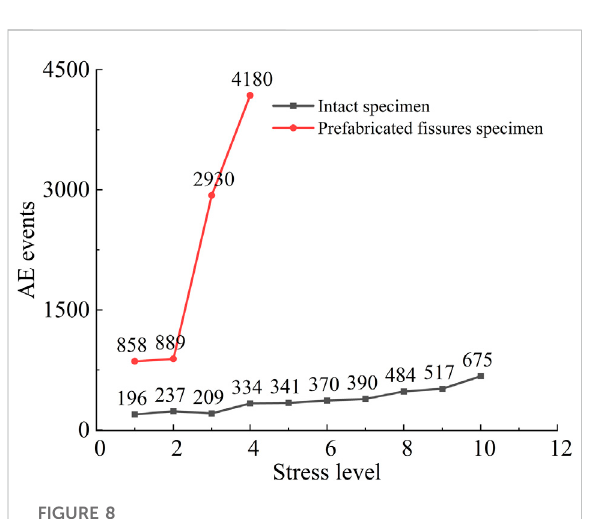
FIGURE 8 AE events of specimens under various stress